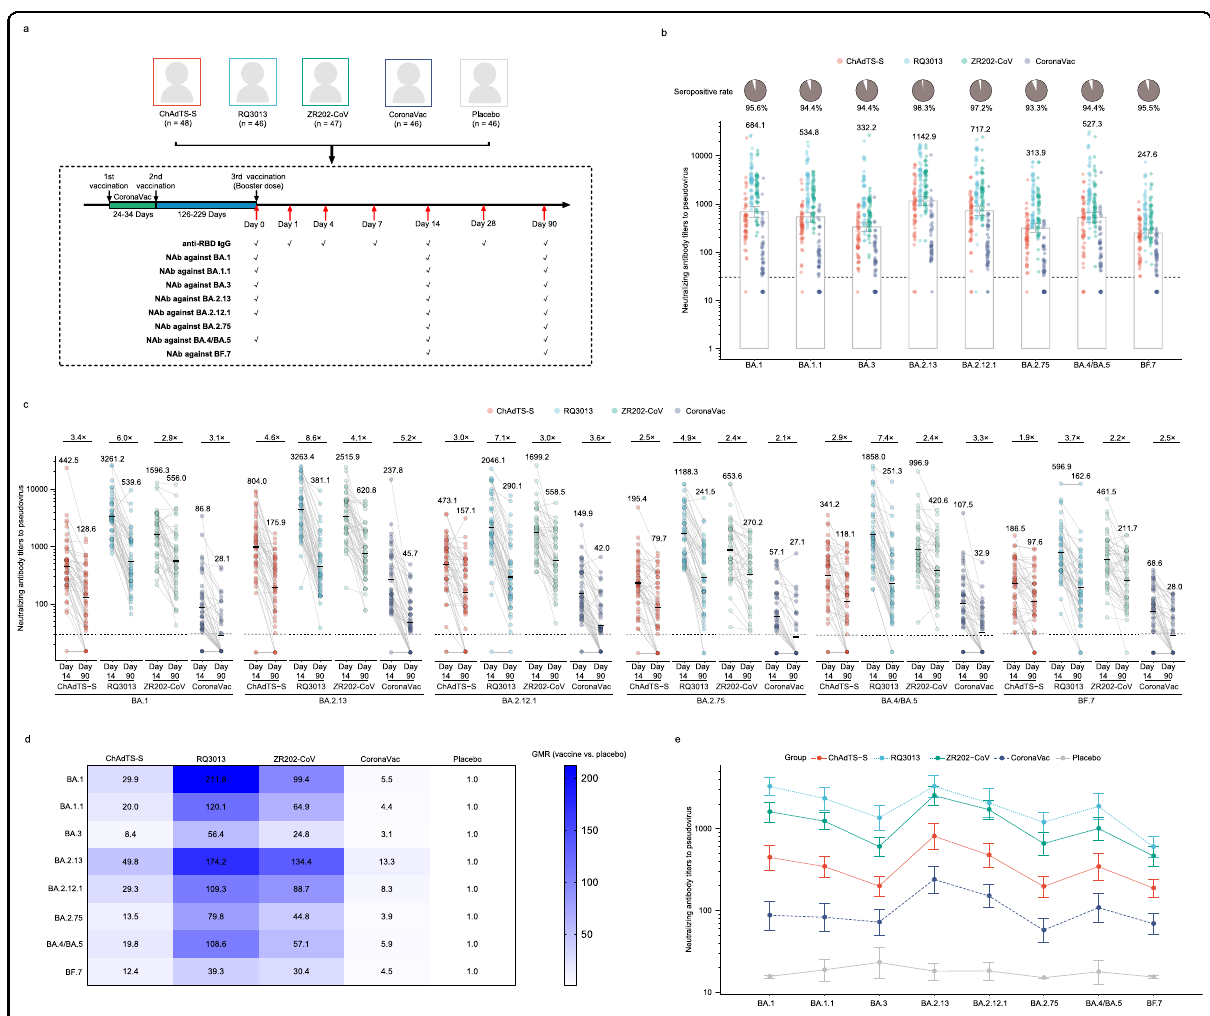
Fig. 1 Magnitude, breadth, and durability of omicron sublineage cross-neutralization elicited by four COVID-19 vaccines as a booster dose. a This fi gure illustrates the study design and the key immunogenicity data for this randomized controlled trial. One participant receiving RQ3013 failed bleeding at day 14 after the booster dose vaccination, resulting in 233 participants in this study. b Neutralizing antibodies against omicron sublineages (BA.1, BA.1.1, BA.3, BA.2.13, BA.2.12.1, BA.2.75, BA.4/BA.5, and BF.7) were measured using pseudovirus test. Data are presented as the geometric mean titers (GMTs) with 95% con fi dence intervals (CI). The titers for individual participants are indicated with datapoints. Seroconversion rates by booster schedules are also presented. c Dynamic changes of neutralizing antibodies against omicron sublineages from day 14 to day 90. d Geometric mean ratios (GMRs) of neutralizing antibodies against omicron sublineages at day 14 after the third dose vaccination across booster regimens. GMRs were calculated using linear regression model by adjusting for the baseline neutralizing antibody levels at day 0 before the booster dose vaccination, the fi rst and second dose interval, and the second and third dose interval by comparing to placebo. e GMTs of neutralizing antibodies against omicron sublineages across booster regimens are presented as the GMTs with 95%